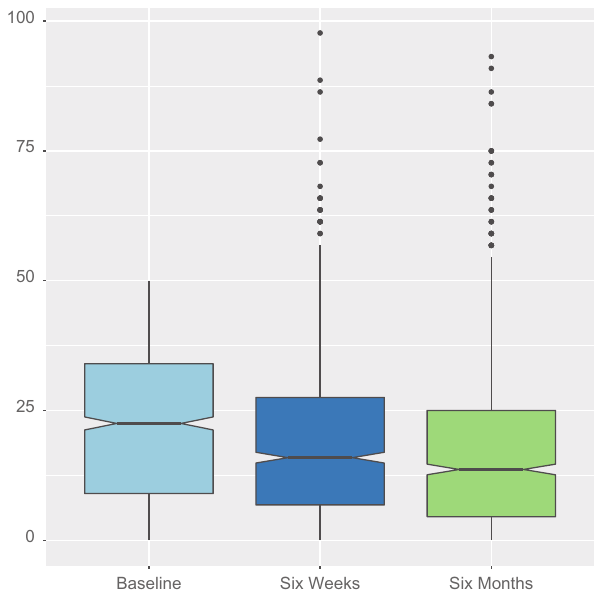
Figure 1: Levels of depression at baseline, the six week, and six month follow up. Scores above 50 are consid- ered to be a clinically significant indication of